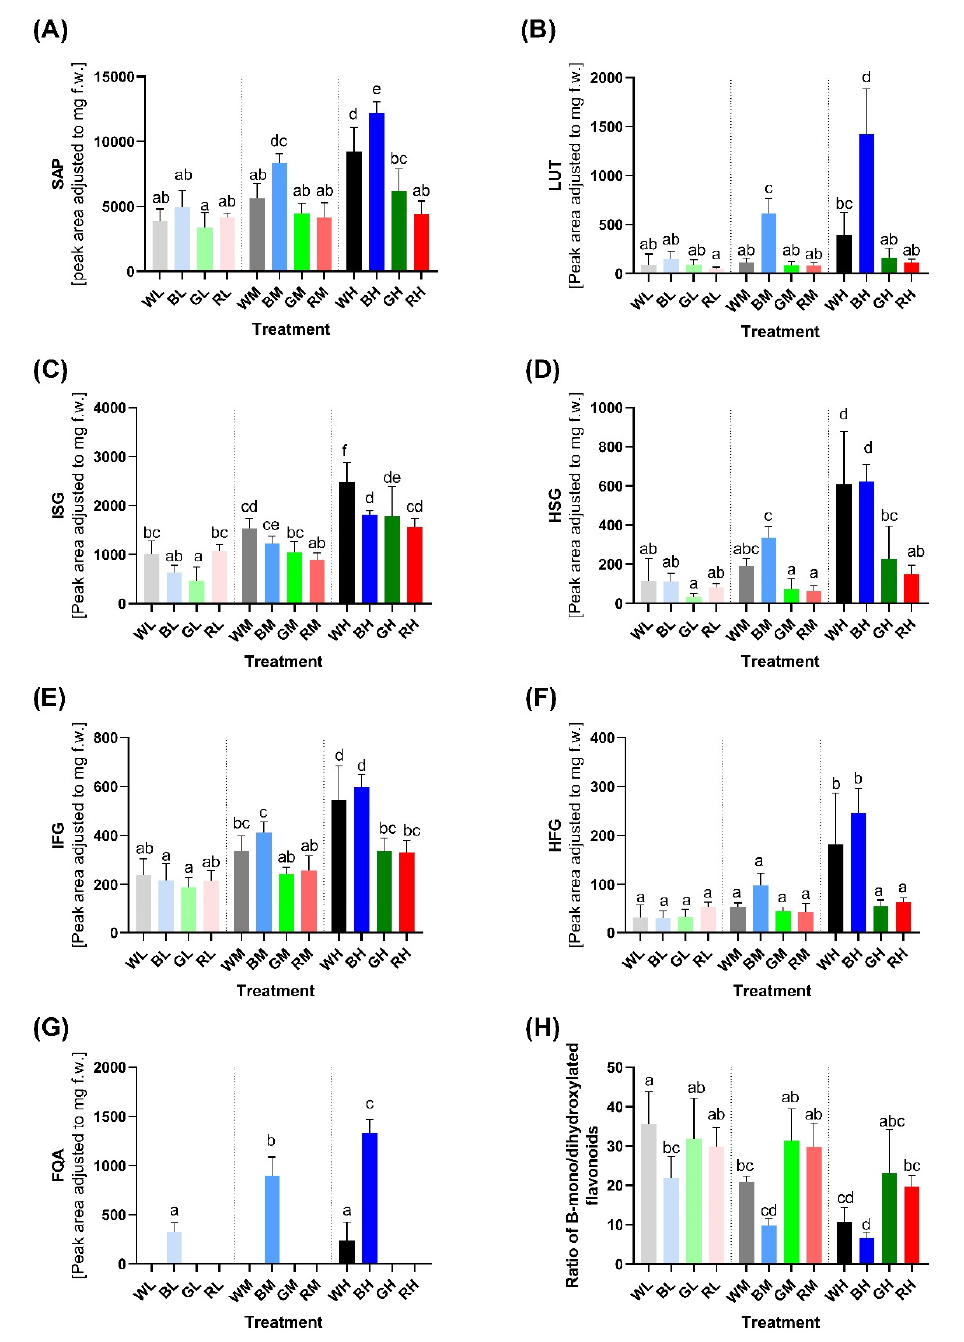
Figure 5. The relative content of individual PheCs in the secondary leaves of Hordeum vulgare L. cv. Bojos acclimated to the light conditions varying in irradiance and spectral qualities. Specifications of light treatment: W (white), B (blue), R (red), G (green), L (low irradiance, 100 µ mol m − 2 s − 1 ), M (medium irradiance, 200 µ mol m − 2 s − 1 ), and H (high irradiance, 400 µ mol m − 2 s − 1 ); n = 5–6 ± SD; the relative content was determined for: ( A )—SAP (saponarin), ( B )—LUT (lutonarin), ( C )—ISG (isovitexin-7-O-[6-sinp]-glc), ( D )—HSG (homoorientin-7-O-[6-sinp]-glc), ( E )—IFG (isovitexin-7-O-[6- fer]-glc), ( F )—HFG (homoorientin-7-O-[6-fer]-glc), ( G )—FQA (feruloylquinic acid), and ( H )—Ratio of B-mono/dihydroxylated flavonoids. Treatments marked above with same letters did not significantly differ based on Tukey's post-hoc test.